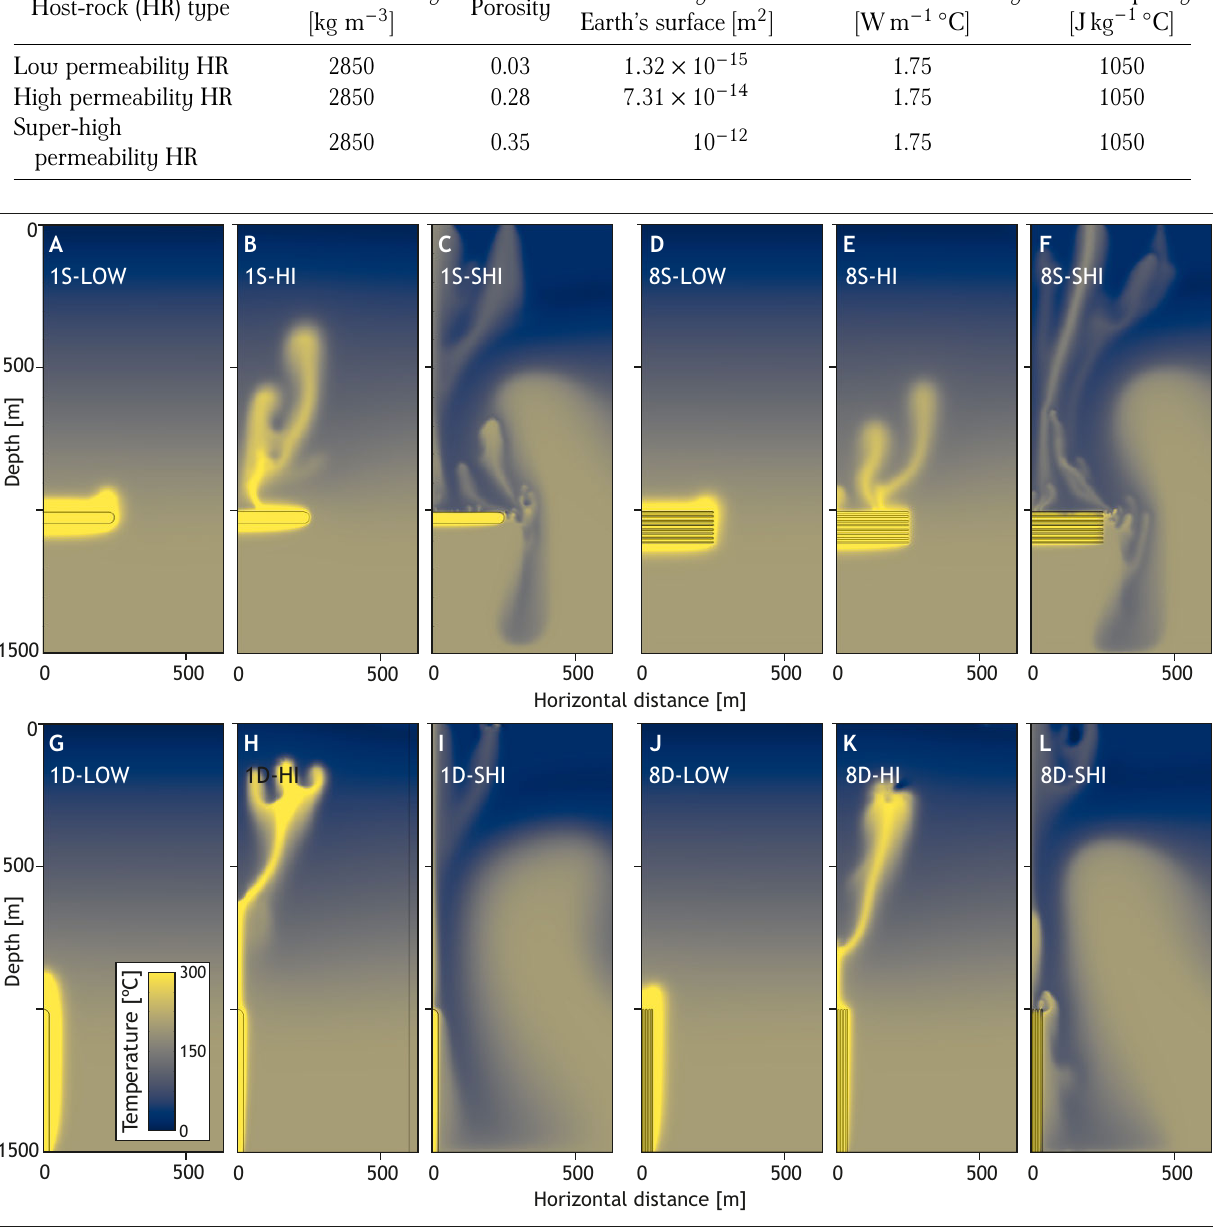
Figure 9: The modelled temperature field ca. 30 years after intrusion. Note that a 600 m-wide section of the models is shown only. The colour scale focusses on the temperature range interesting for geothermal exploration. Temperatures above 300 °C do occur. See Table 3 for a list of all models. See text for